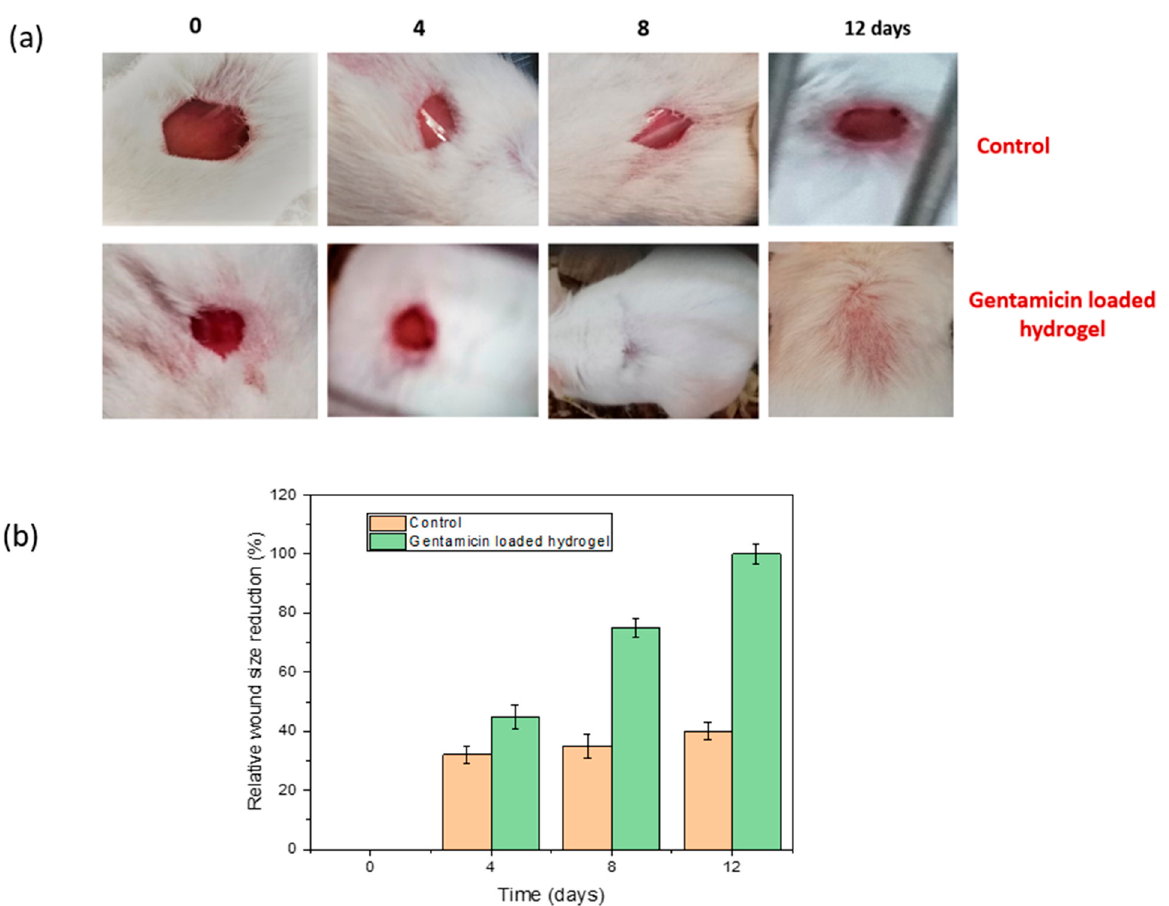
Figure 14. ( a ) Photographs of wounds treated with normal gauze and gentamicin loaded hydrogel. ( b ) Evaluation of relative wound size reduction .